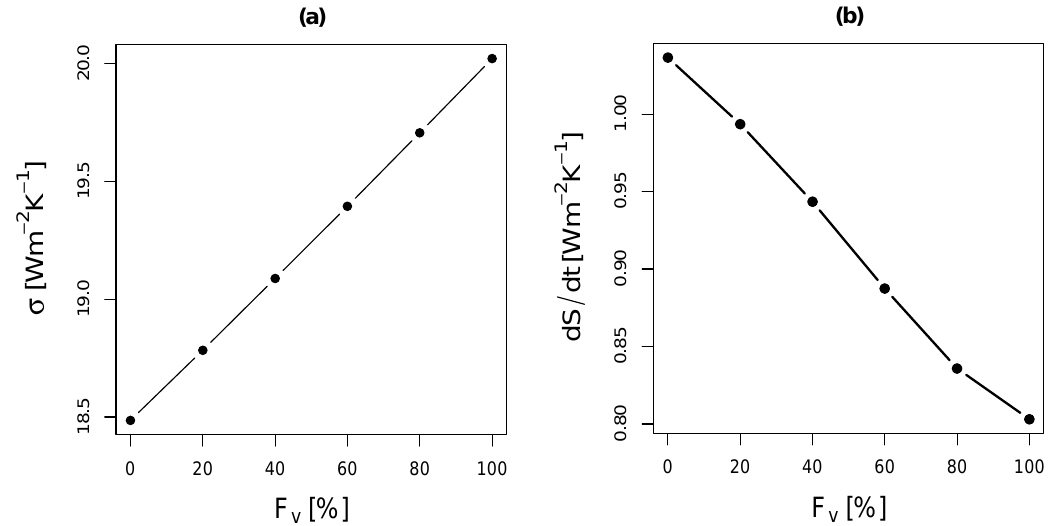
Fig. 8. Values of (a) entropy production and (b) overall entropy budget summed over the diurnal cycle as a function of fractional vegetation